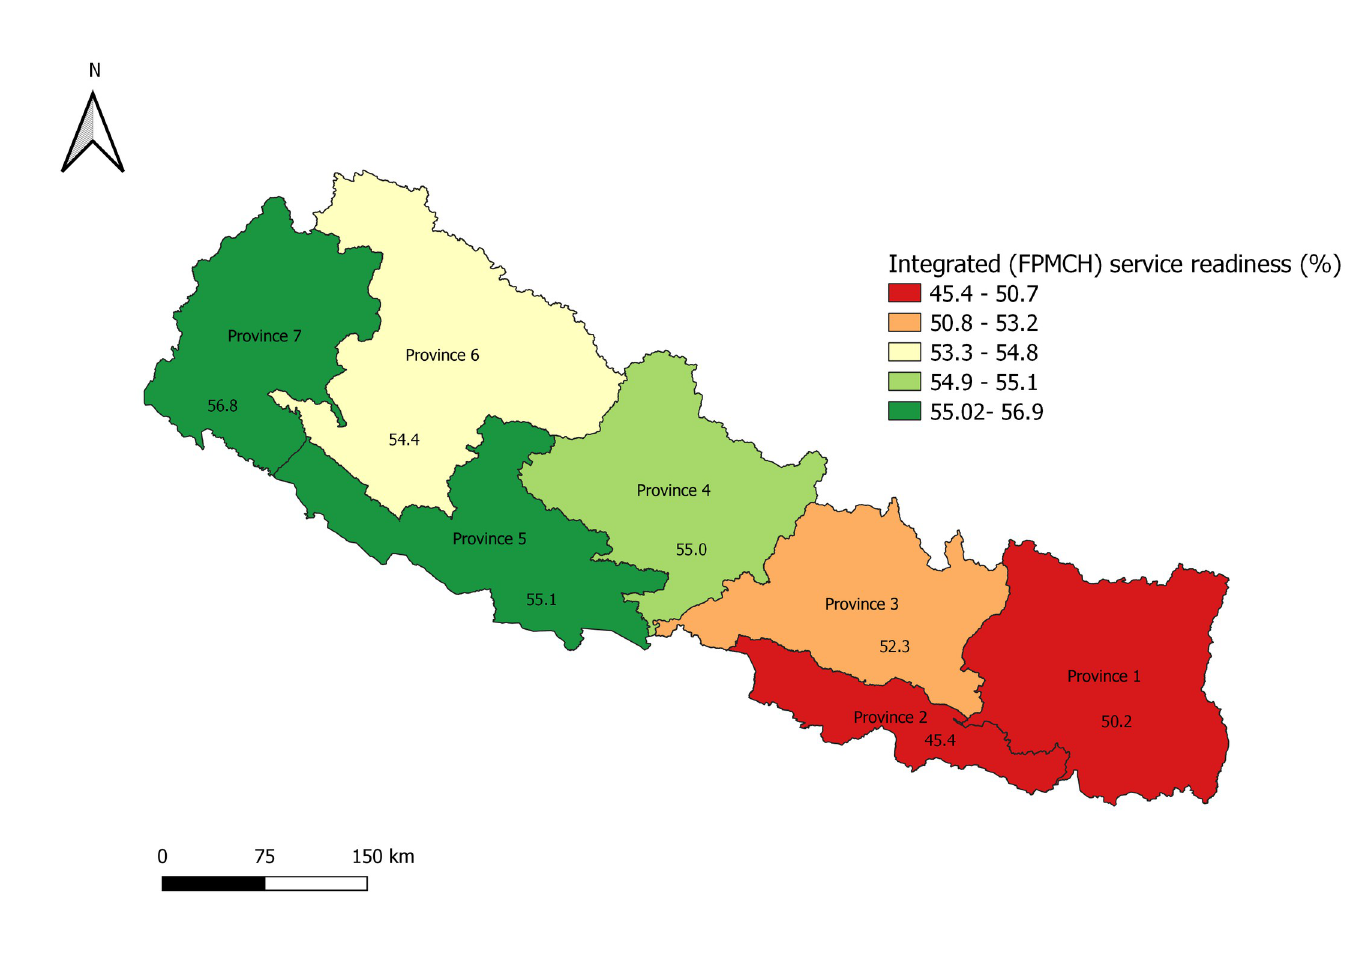
Fig 1. Mean service readiness score for integrated FPMCH services according to province in